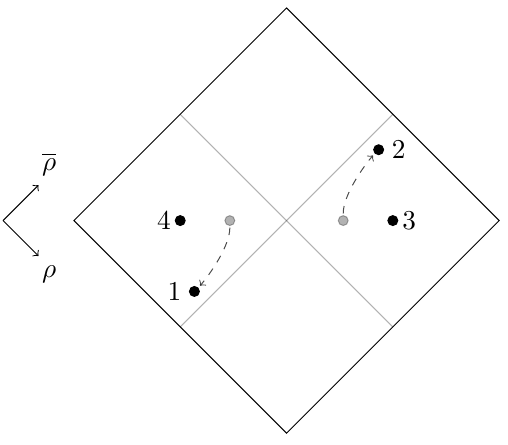
Figure 11. The Regge limit in the con(cid:12)guration (5.2). We boost points 1 and 2 while keeping points 3 and 4 (cid:12)xed. This con(cid:12)guration is related by an overall boost to the one in (cid:12)gure